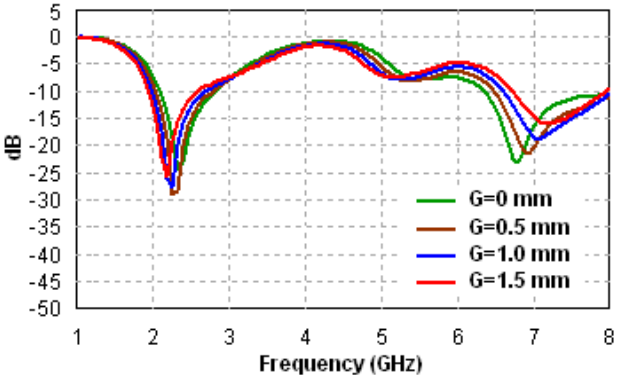
Figure 7: The S 11 responses of the 3rd iteration Koch fractal monopole antenna of Figure 6(a) with G as the parameter